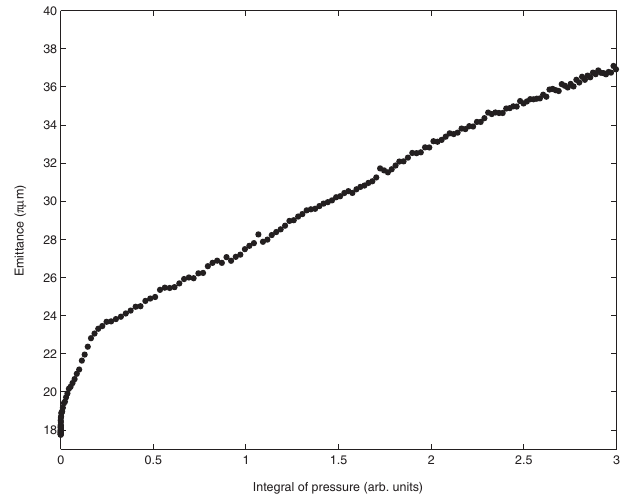
FIG. 5. Blue beam emittance observed by the IPM versus the integral of the dynamic pressure rise at the Blue ring warm section